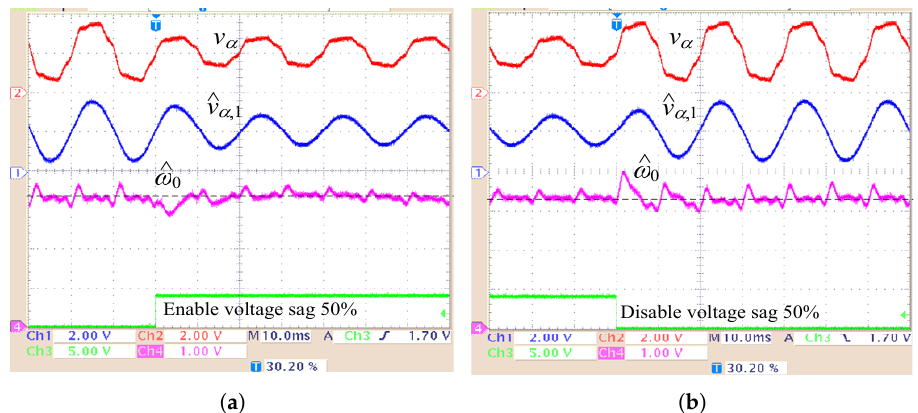
Figure 14. Transient responses of the SRF-based PLL after a voltage sag ( a ) from 100% to 50%, and ( b ) back from 50% to 100%, while keeping f 0 = 50 Hz and with harmonic distortion: (from top to bottom) v α , ˆ v α ,1 ( y -axis: 400 V/div), ˆ ω 0 ( x -axis: 10 ms/div; y -axis: 97.66 rad/s/div), and voltage-sag enable signal ( x -axis: 10 ms/div in all